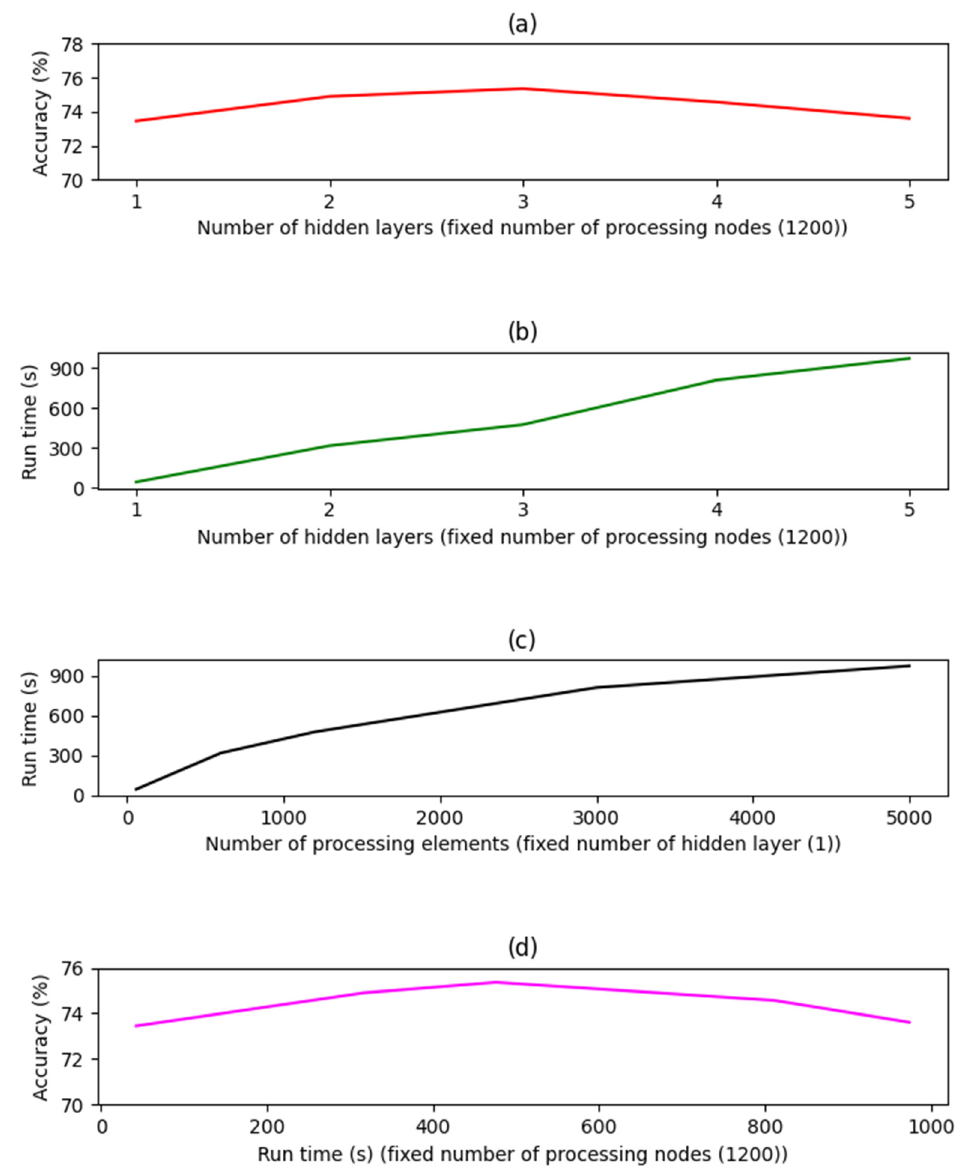
Figure 8. ( a ) Accuracy against the number of layers; ( b , c ) runtime against the number of hidden layers and the number of processing nodes; and ( d ) accuracy against runtime.